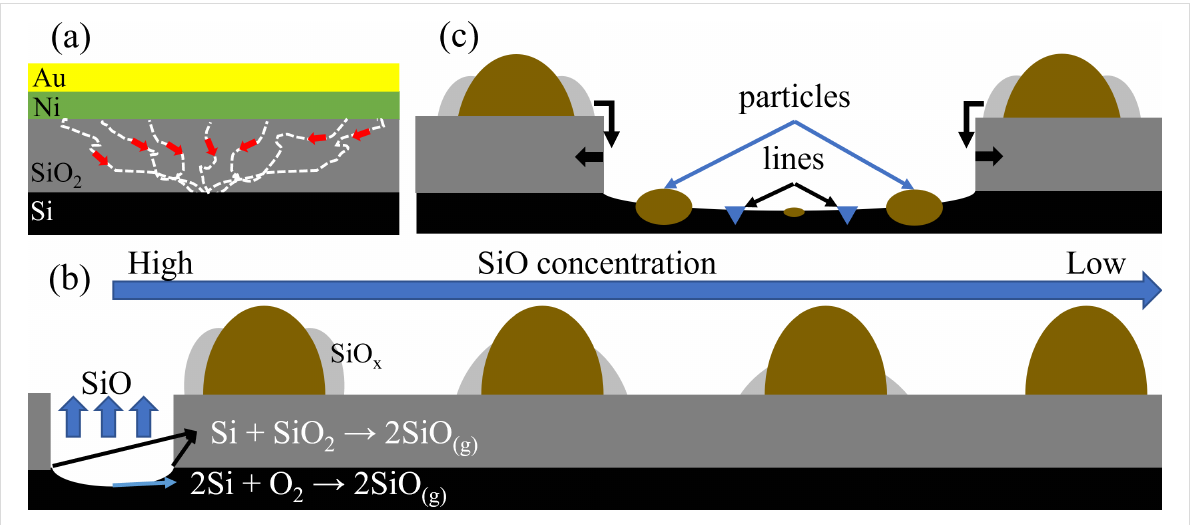
Figure 4: Formation mechanisms at elevated temperatures. (a) As-deposited bilayers and Au/Ni diffusion along nanochannels (dashed lines) in the SiO 2 layer. All dashed lines pointing to the common point at the SiO 2 /Si interface aim to highlight the enhancement of SiO 2 decomposition by the thin films. (b) SiO concentration gradient outside the decomposition cavity and cross sections of nanoflowers with changing branch length. (c) Cross sections of particles and epitaxial line structures inside the decomposition